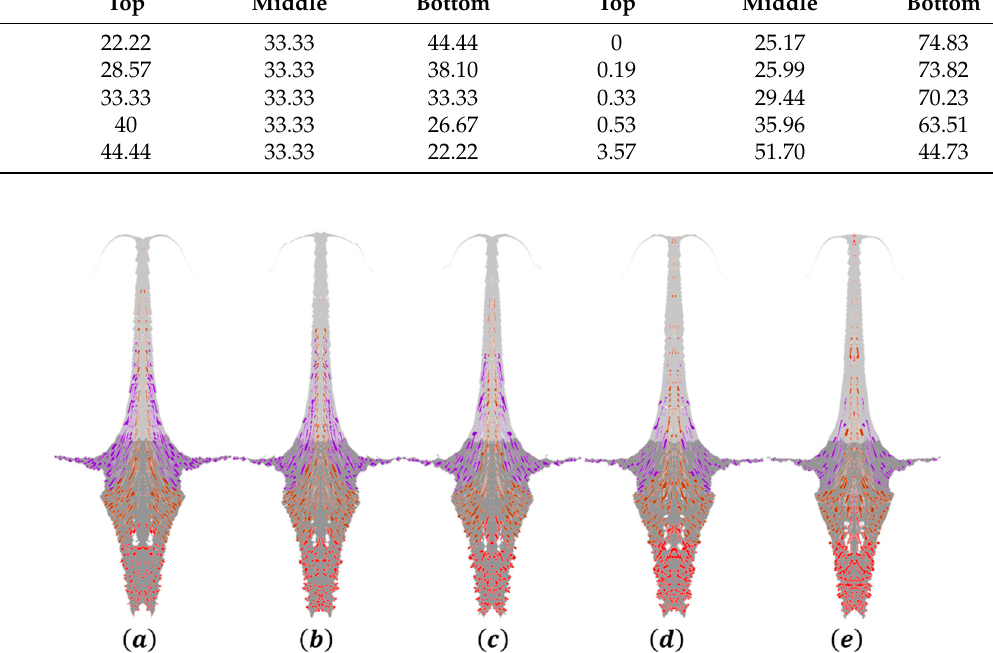
Table 4. Al content in HSSJ for different liner granule distributions according to ρ liner .